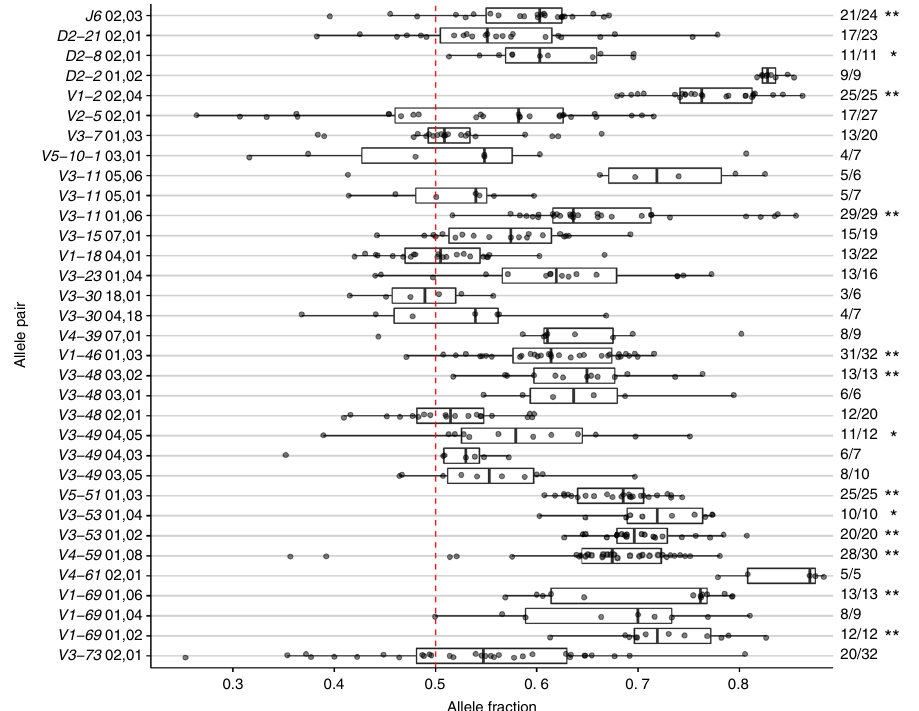
Fig. 4 Biased allele usage. Box plot of allele pairs relative usage of heterozygous individuals. Only allele pairs which were observed in more than 5 individuals are shown. Each point represents an individual. The allele fraction ( X axis) corresponds to the allele that is written fi rst in each row, and is the dominant allele in most individuals. Asterisks indicate allele pairs with a statistically signi fi cant difference in the number of individuals with the same dominant allele. Statistical signi fi cance was determined with a binomial single sample sign test (see Methods, * indicates p value <0.05, ** indicates p value